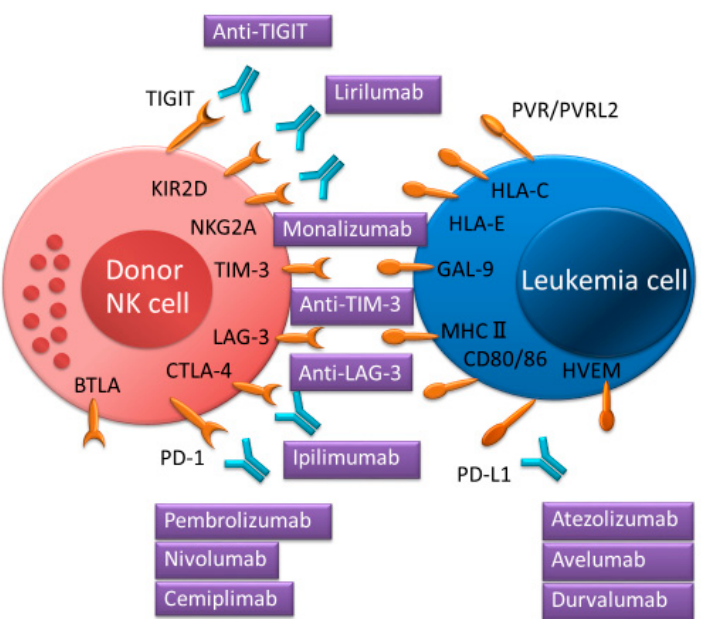
Figure 4. Immune checkpoint inhibitors for targeted NK cell proteins and interactions between immune checkpoint receptors and ligands enhancing NK cell function.